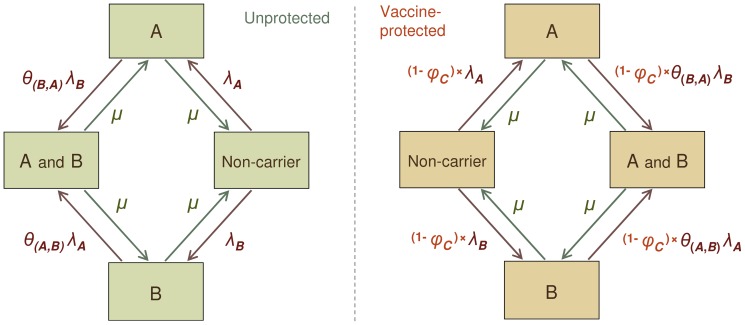
Model for transmission of pneumococcal carriage.Each individual in the population belongs to one of 67 possible states: susceptible to carriage, carrier of one of the 11 model types, or simultaneous carrier of any two of the 11 model types. For simplicity, the figure presents the model for two of the 11 model types, denoted as A and B. The flow of individuals is governed by rates of clearance and acquisition, as marked at each arrow. The rates of acquisition depend on the number of carriers in the mixing group which the individual belongs to and, for already carrying individuals, also on the ranking order of the categories corresponding to the incoming and the carried type (see text). The rates of acquisition for vaccine-protected individuals are reduced by a factor (1-φc). Vaccinated individuals lose protection against carriage with a waning rate (see text) and move to an unprotected compartment. The rate of clearance μ is assumed same, regardless of the vaccination status, the type(s) and the number of types carried.